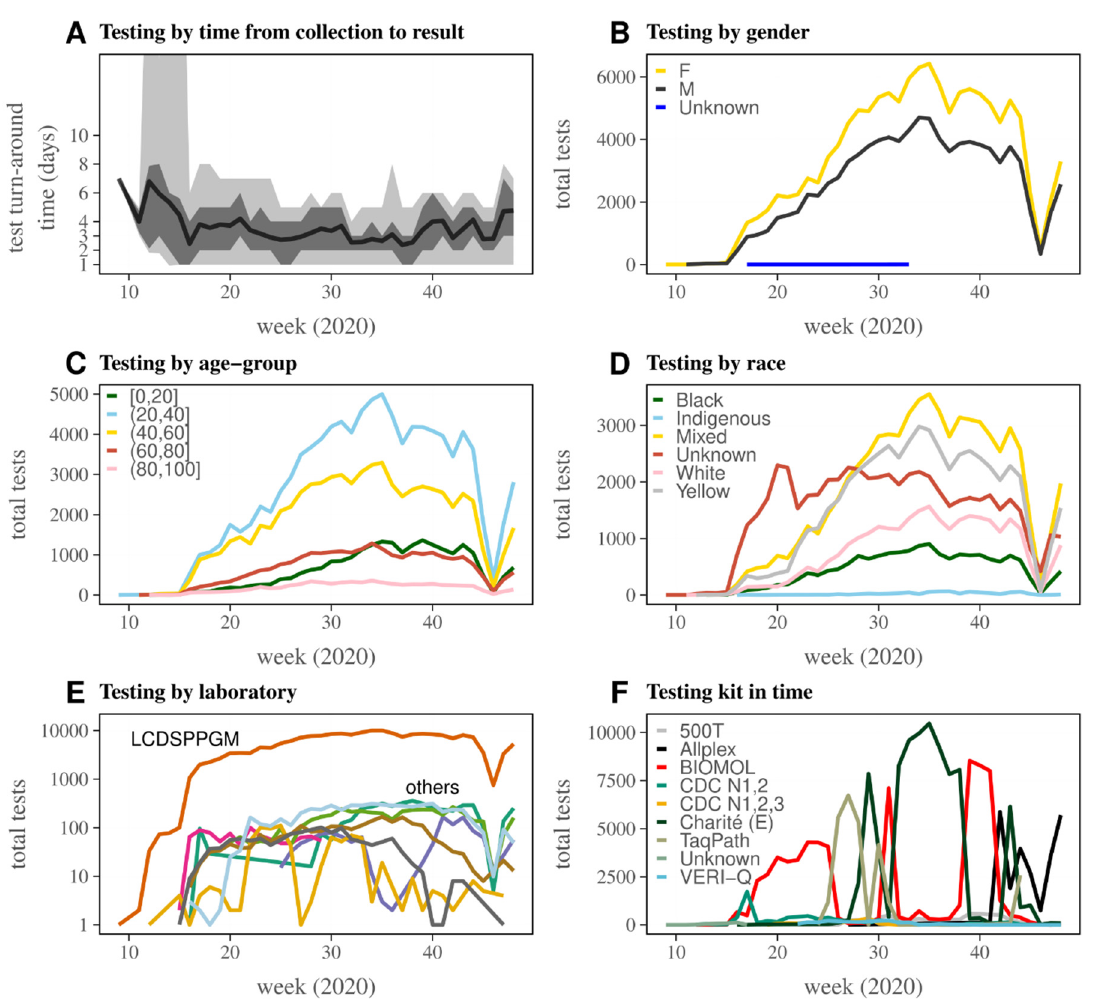
Figure 3. Summary of SARS-CoV-2 RT-PCR testing in Bahia, March-November 2020. ( A ) Test turn- around time (number of days between sample collection test result). Dark grey shaded area is the 95% quantile of the test turn-around time across all tests, light grey shaded area is the 75% quantile, and the black line is the mean; all data are per week. ( B ) Total weekly tests by gender and ( C ) age group in years (trimmed to maximum 100 years), both according to color legend. ( D ) Total weekly tests by reported race according to color legend. ( E ) Total weekly tests by performing laboratory, with highest performing laboratory LCDSPPGM in purple and others with varying colors. For a list of all laboratories, see Table S2. ( F ) Total weekly tests by test kit used according to color legend. For details on kits, see Table S1. ( B – F ) For total of tests per variable, see Supplementary Figure S1.